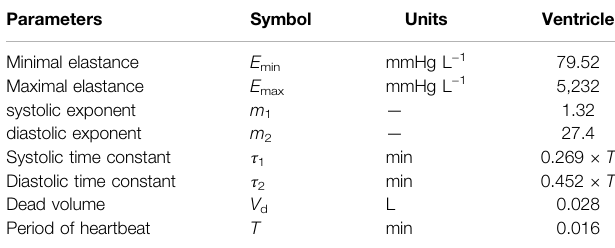
TABLE 2 | Parameters for the time varying ventricular compliance in the heart